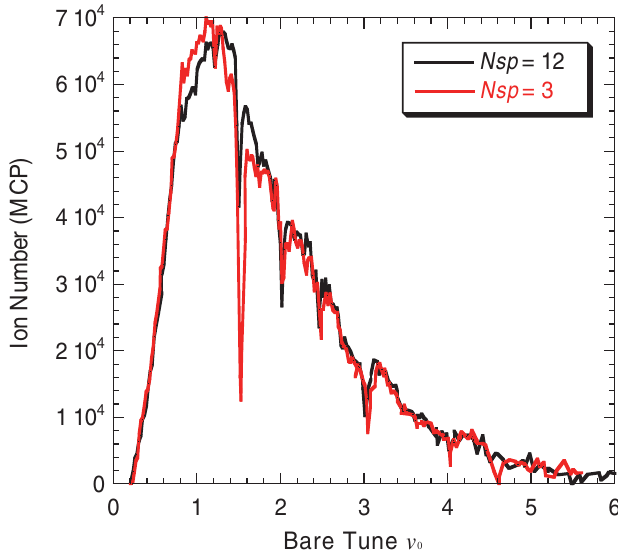
FIG. 6. (Color) Experimental results obtained under the same conditions as modeled in the tracking simulations in Fig.